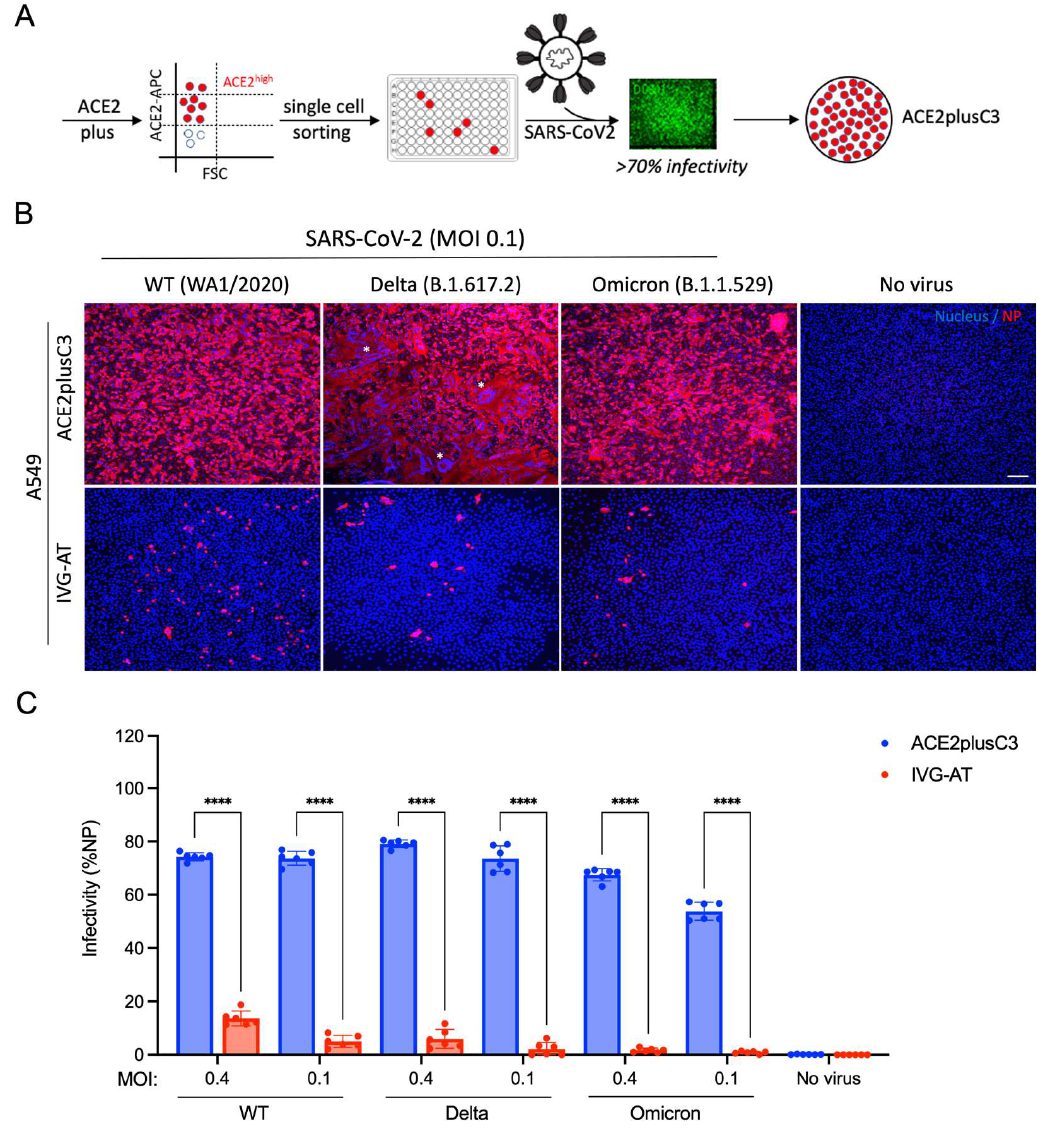
Figure 2. The characterization of single-cell clones from the ACE2plus cell population. ( A ) The experimental scheme to establish the ACE2plusC3 line. The commercial A549-hACE2-TMPRSS2 cell line (IVG-AT) was tested using the same experimental conditions. ( B ) Virus-infected cells are visualized by immunofluorescence staining of the nucleocapsid protein of SARS-CoV-2 at 48 h post-infection. Scale bar, 200 µm. Syncytia are indicated by asterisks. ( C ) The percent infectivity is determined by the number of NP+ (nucleocapsid protein) cells out of the total cells. The data are expressed as mean ± SD. n = 6 biological replicates. ****, p < 0.0001.